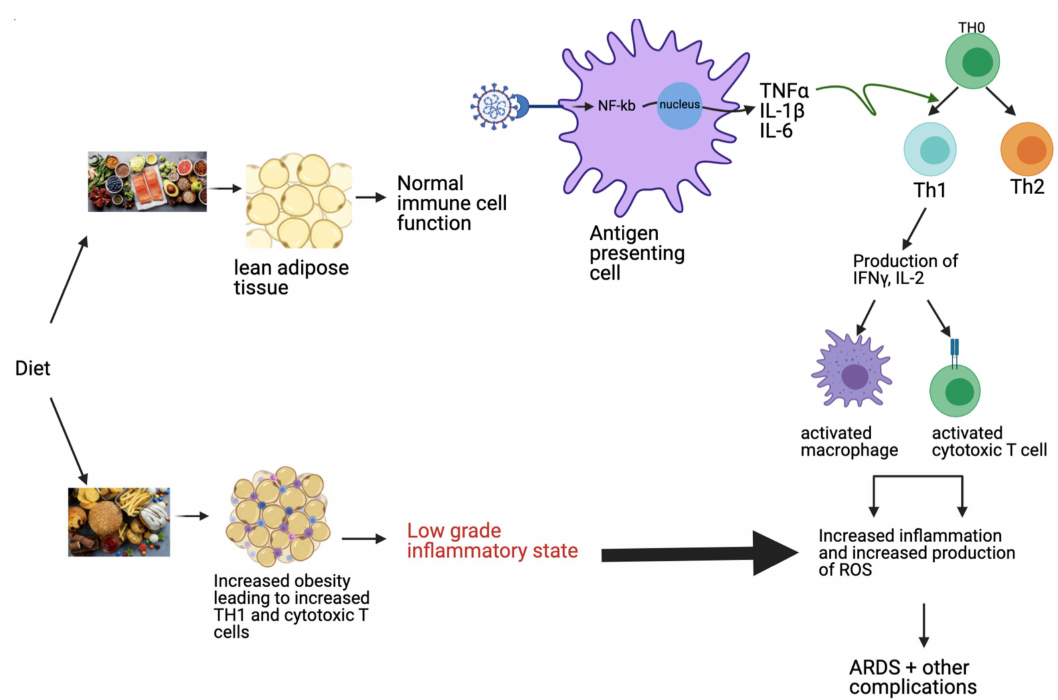
Figure 1. Proposed modulation of the immune pathway by diet. The Western diet, consisting of high fat, refined sugar, and saturated carbohydrates, leads to increased obesity, as well as an increase in TH1 and cytotoxic T cells, resulting in a low-grade inflammatory state. This inflammatory pathway is exacerbated in COVID-19 through the virus’s ability to increase pro-inflammatory cytokines, resulting in ARDS and other morbid complications. In contrast, the Mediterranean diet, consisting of fruits, vegetables, nuts, and fish maintains lean adipose tissue, contributing to a balanced immune system and absent or improved inflammatory state. Nuclear factor kappa B (NF-kb), tumor necrosis factor alpha (TNF- α ), interleukin-1 beta (IL-1 β ); interleukin-6 (IL-6); interferon gamma (IFN γ ); interleukin-2